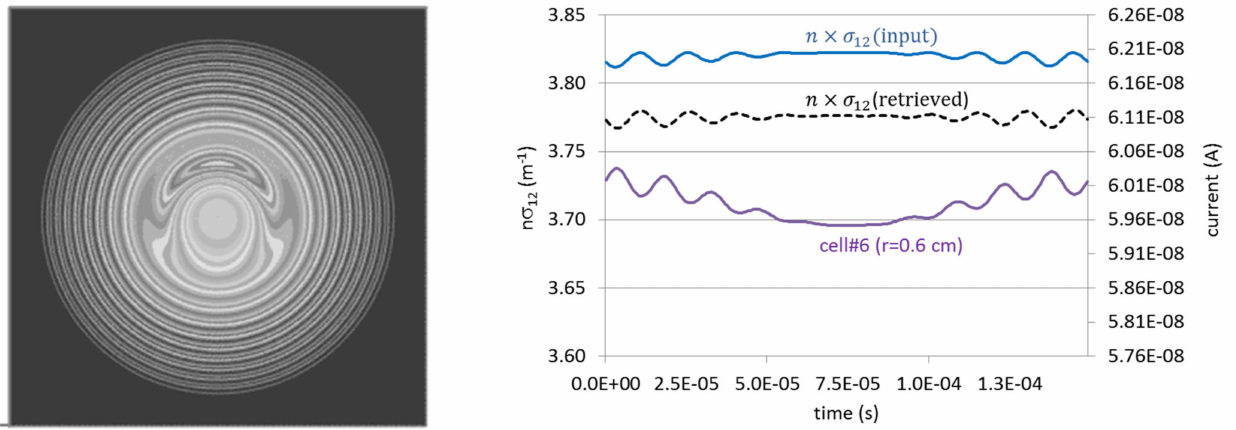
Figure 6. Left: illustration of the ‘ n sigma ’ contour plot of the m = 1 mode (plasma radius = 8.5 cm); Right: the evolution of the inputted and retrieved ‘ n sigma ’ (left scale) at the ionization volume in position r = 0.6 cm and the evolution of the detector current (right scale) for the secondary ions emerging from the ionization volume (reprinted from [8]).